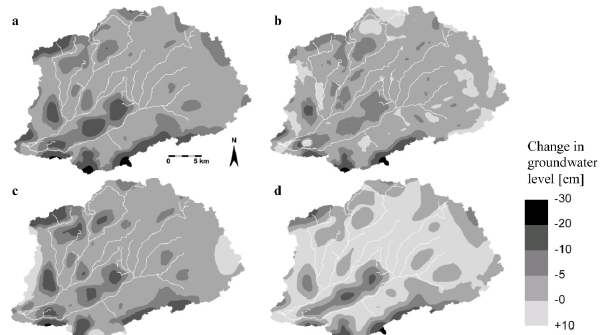
Fig. 10. Spatial distribution of the simulated change (average fu- ture minus reference) in temporally averaged: (a) groundwater level; (b) mean highest groundwater level (MHGL); (c) mean low- est groundwater level (MLGL); and (d) mean spring groundwater level (MSGL). Positive changes indicate an increase in ground- water level, negative changes indicate a decrease in groundwater level from the reference status to the average future state. Rivers are shown in white.